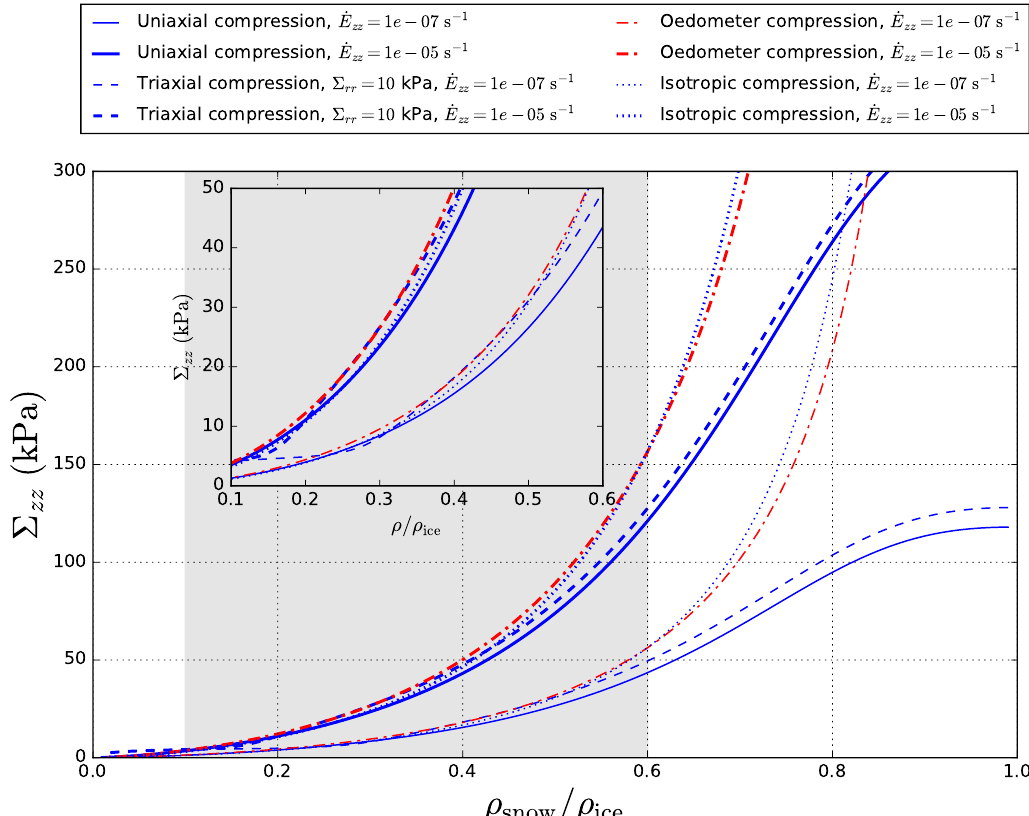
Figure 12. Predicted axial stress level (for n = 4 . 5 and A = 1 . 5 × 10 − 3 MPa − n s − 1 ) with respect to snow relative density for two imposed strain rates (line thickness) and for four classical laboratory tests: an oedometric compression test (dash-dotted line), a uniaxial compression test (solid line), a triaxial compression test (dashed line) and an isotropic compression test (dotted line). The inset plot provides a zoom on the classical range of snow densities observed experimentally (gray